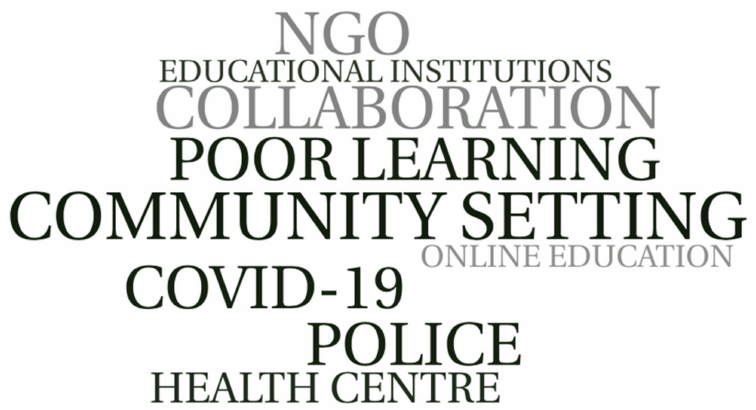
Figure 7. World cloud alluding to arguments in relation to the community setting. Self-made